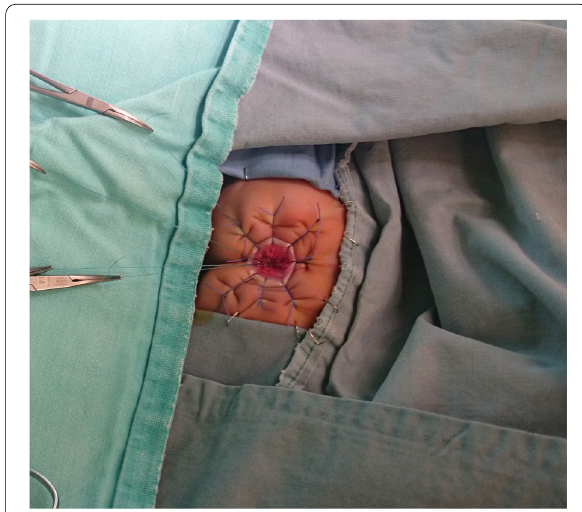
), and the fibrous cord was seen connecting +